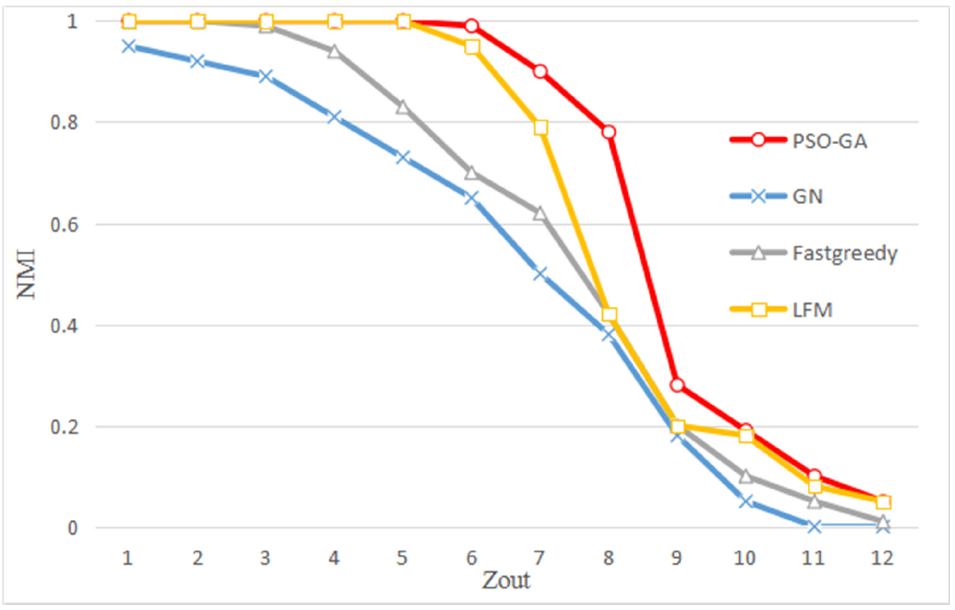
Figure 3. Comparison of results of various algorithms on the artificially generated network.